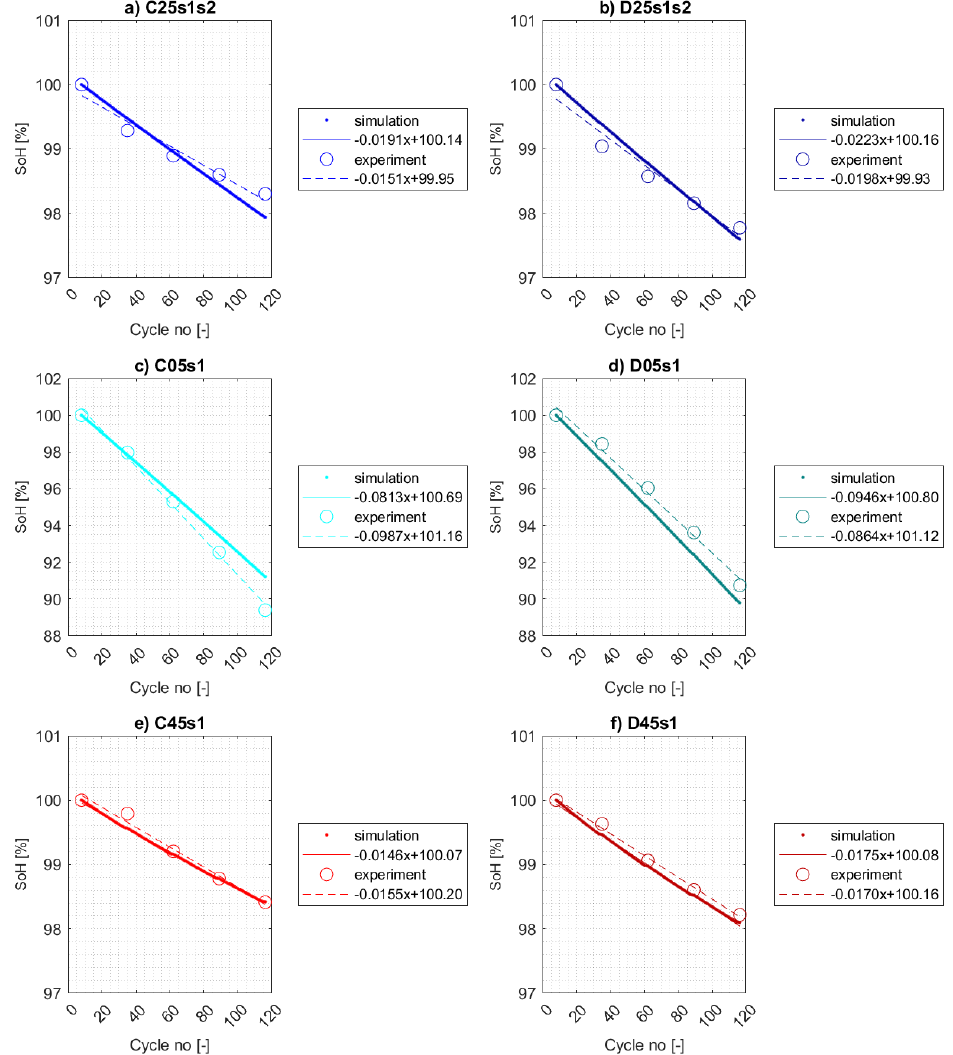
Figure 20. Comparison of the simulation and experimental SoH results for all the cycled cells at temperatures 25, 5 and 45 ◦ C. Simulations have been performed with the parameter values from the second adjustment according to Table